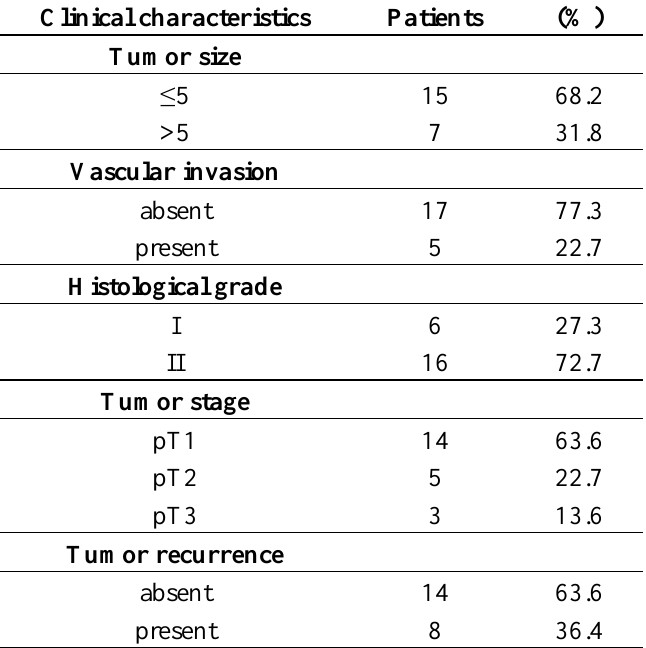
Table 1. Clinicopathological profiles of non-alcoholic steatohepatitis (NASH)-related hepatocellular carcinoma